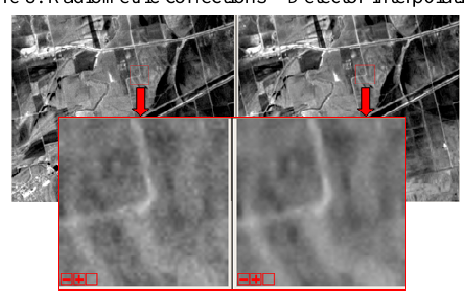
Figure 8: Radiometric corrections – Detector interpolation